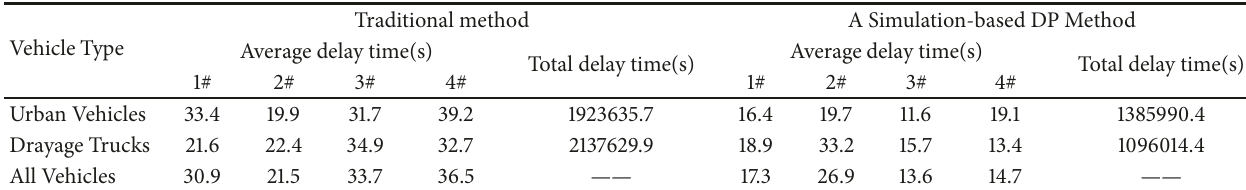
Table 7: Comparative analysis of results of two